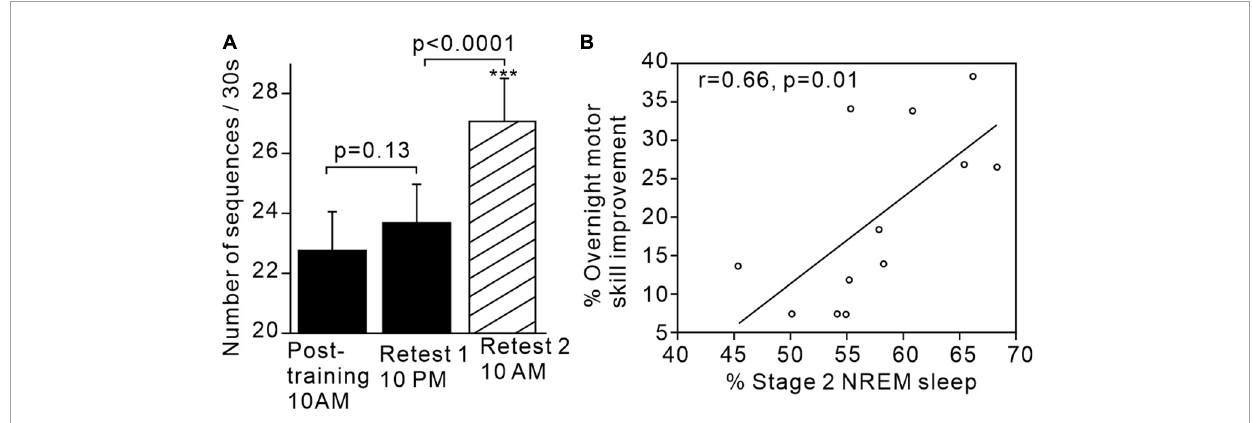
FIGURE1 Motor skills improve after sleep and are associated with increased proportion of stage 2 sleep. (A) Significant increase in motor sequence performance after sleep but not after the same time period awake. (B) Positive correlation between proportion of stage 2 sleep and overnight motor performance improvement. Figures reproduced with permission from Walker et al. (2002). *** p <